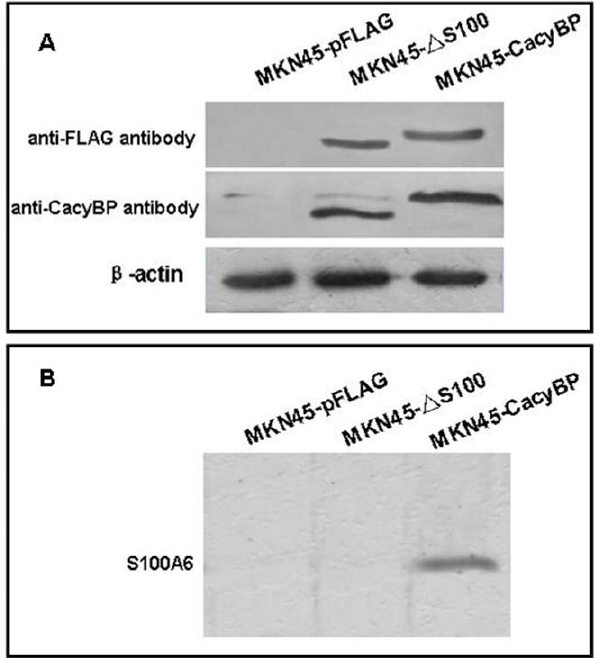
Figure 2. Interaction of S100A6 and CacyBP/SIP in the MKN45 gastric cancer cell line. (A) Western blot analysis of the transfectants CacyBP/SIP and CacyBP/SIP D S100 transfectants with anti-FLAG and anti-CacyBP antibodies. b -actin was used as a loading control. (B) Co- immunoprecipitation assay to detect an interaction between S100A6 and CacyBP/SIP in MKN45 cells. After incubation with anti-CabyBP antibody, the binding sites were detected by anti-S100A6 antibody.